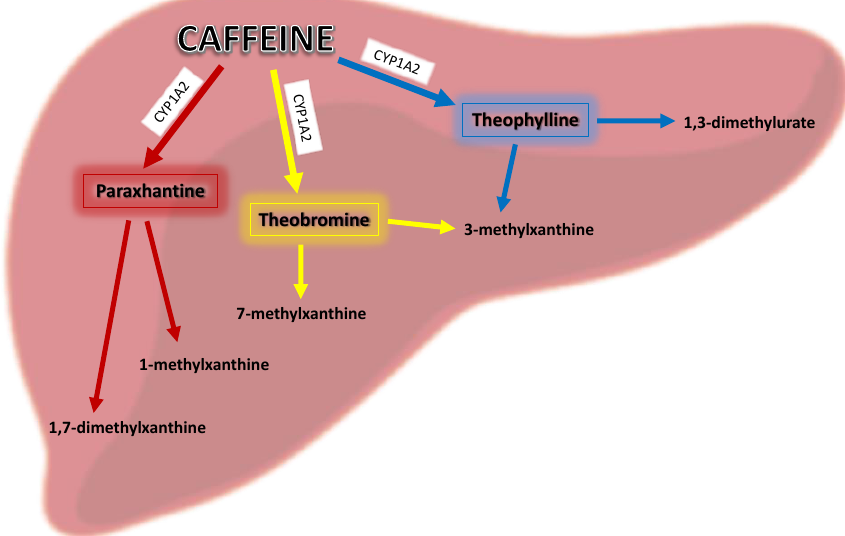
Figure 2. The main pathways of caffeine metabolism in the liver.